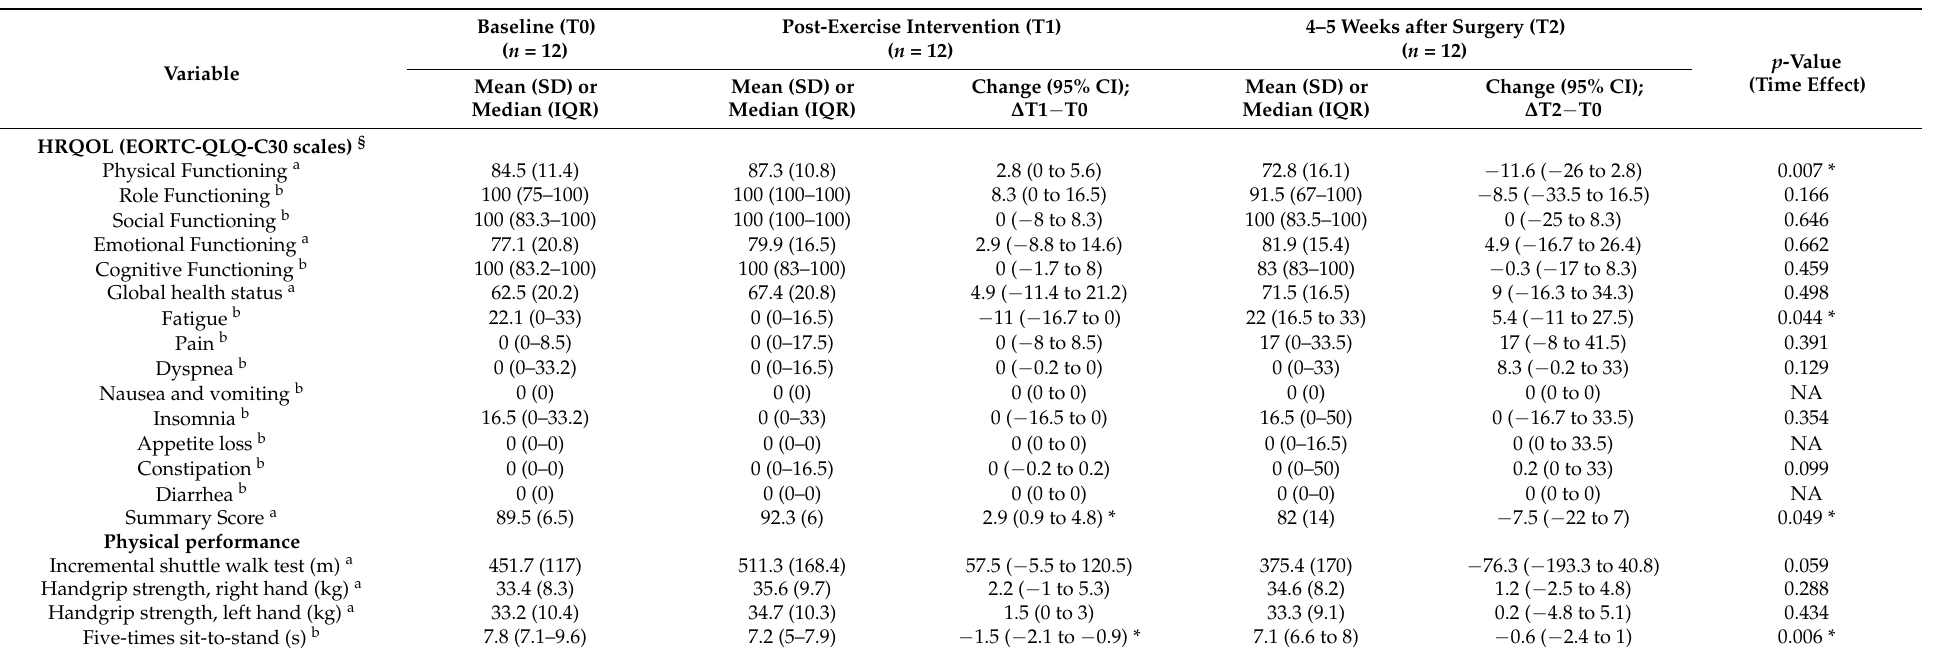
Table 3. Measures of health-related quality of life and physical performance at each assessment